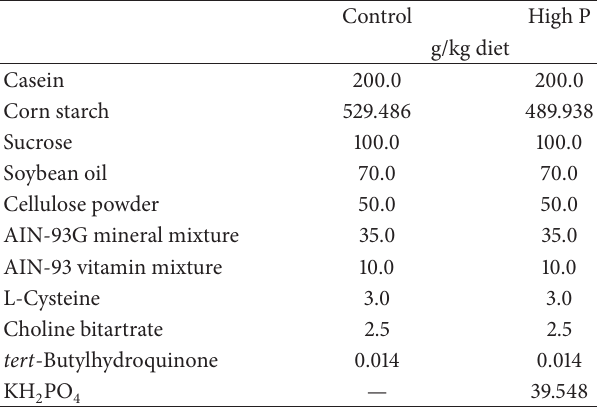
Table 1: Composition of the experimental